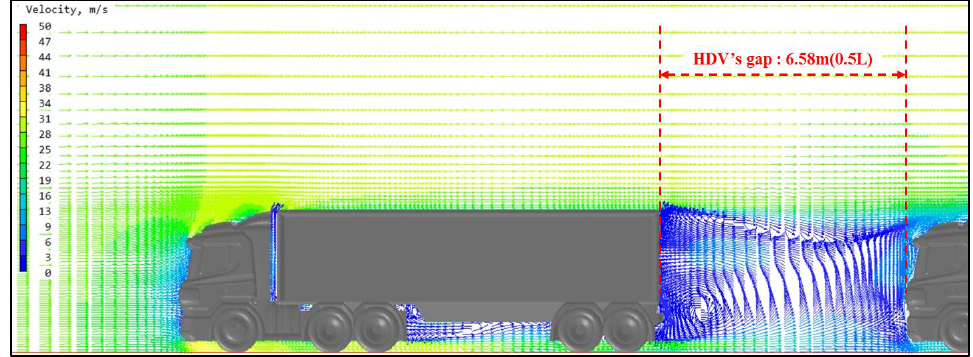
Figure 7. Vortex generated in between LV and FV1 at 0.5 L and 100 km/h in speed.